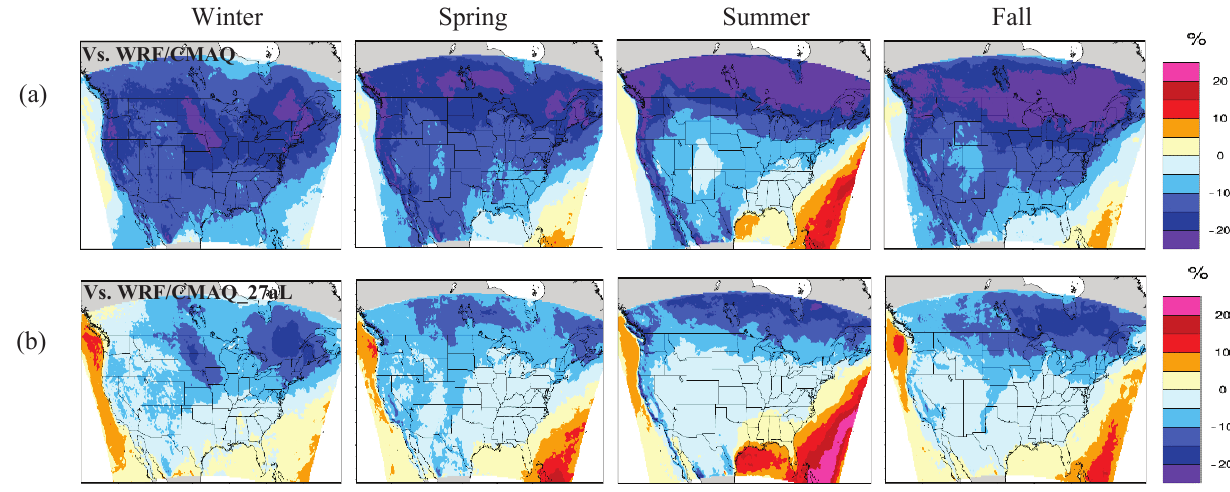
Figure 8. Differences in the seasonal averaged DM8A BC1 / BCT (%) between WRF / CAMx and WRF / CMAQ (WRF / CAMx minus WRF / CMAQ) (a) and between WRF / CAMx and WRF / CMAQ_27aL (WRF / CAMx minus WRF / CMAQ_27aL) (b) in the analysis do- main. surface. Although WRF / CAMx does not represent this pro- cess, the DM8A BC1 / BCT in WRF / CAMx is usually lower than that in WRF / CMAQ_27aL (Fig. 8b) over land.